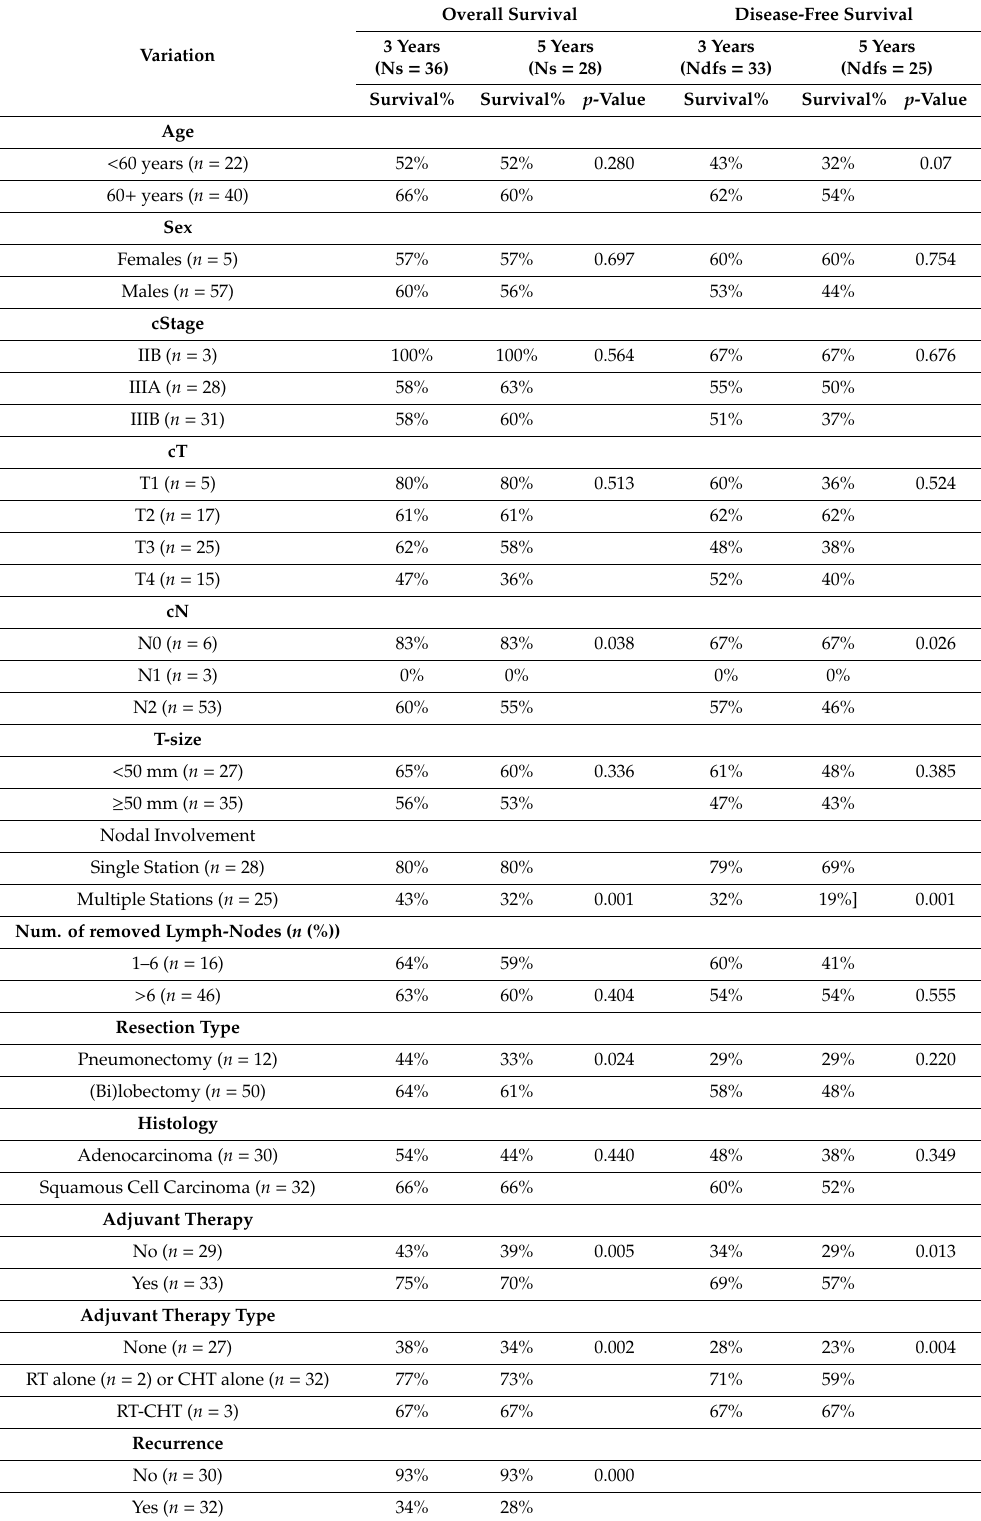
Table 3. Survival and DFS at 3 and 5 years from surgery; p -value of Log Rank Test for the comparison of survival